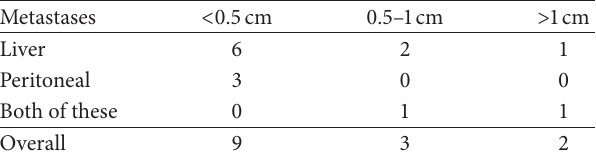
Table 1: Metastases detected by